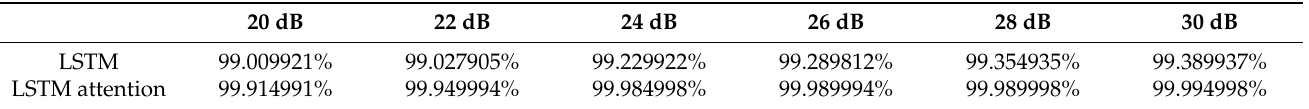
Table 5. Comparison of accuracy between the LSTM network and LSTM attention